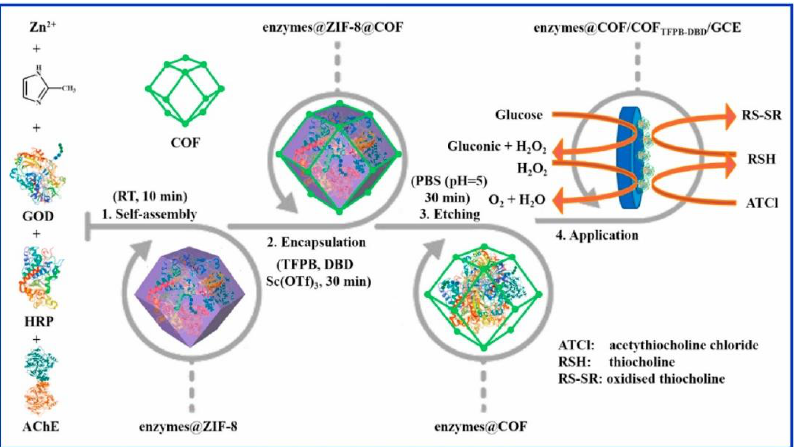
Figure 5. Schematic illustration of preparation and application of enzymes@COF microcapsule. Reprinted with permission from Ref. [75]. Copyright 2021 Elsevier.